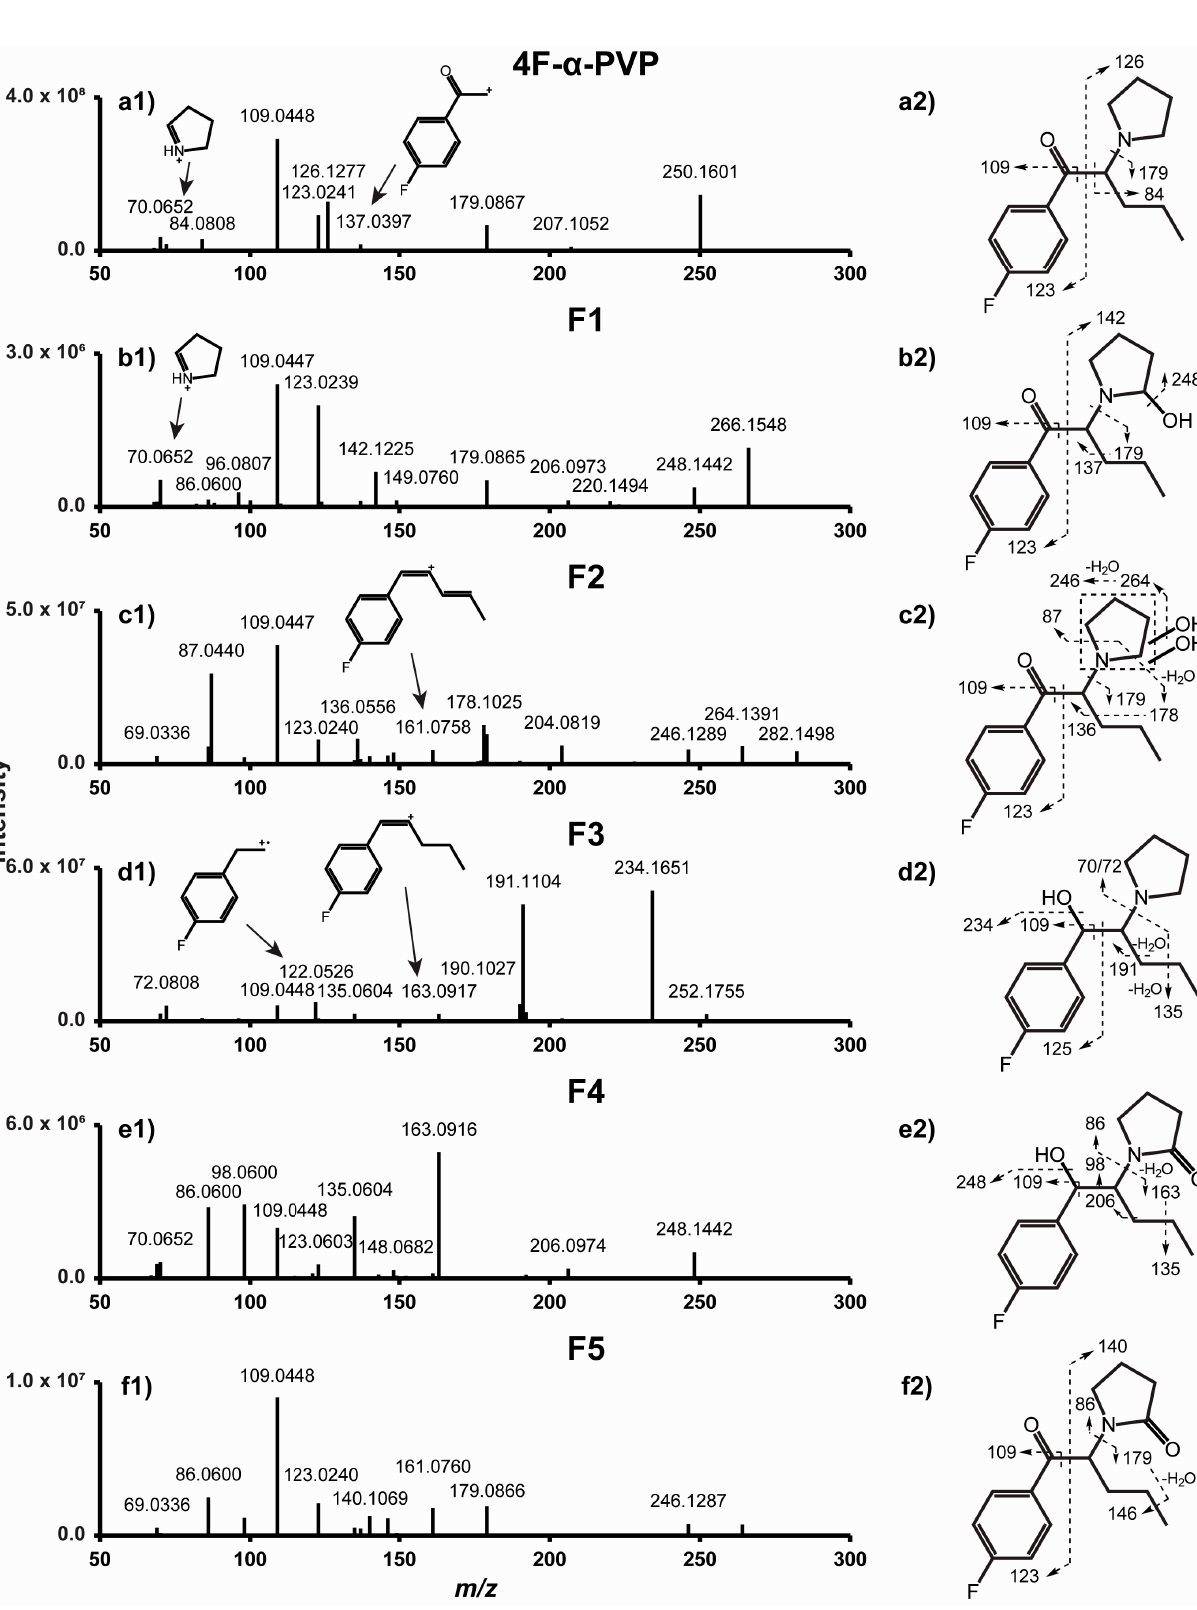
Figure 3. Product ion spectra of 4F- α -PVP ( a1 ) and metabolites F1 ( b1 ), F2 ( c1 ), F3 ( d1 ), F4 ( e1 ), and F5 ( f1 ), and their postulated fragmentation patterns ( a2 – f2 , respectively). Dashed arrow indicates fragmentation